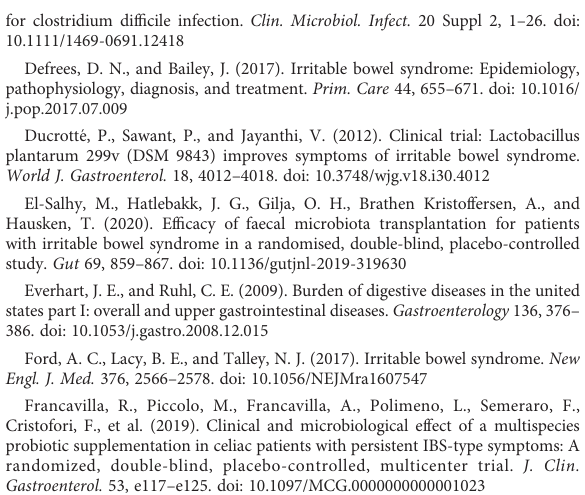
SUPPLEMENTARY TABLE 2 Changes of IBS related symptoms.